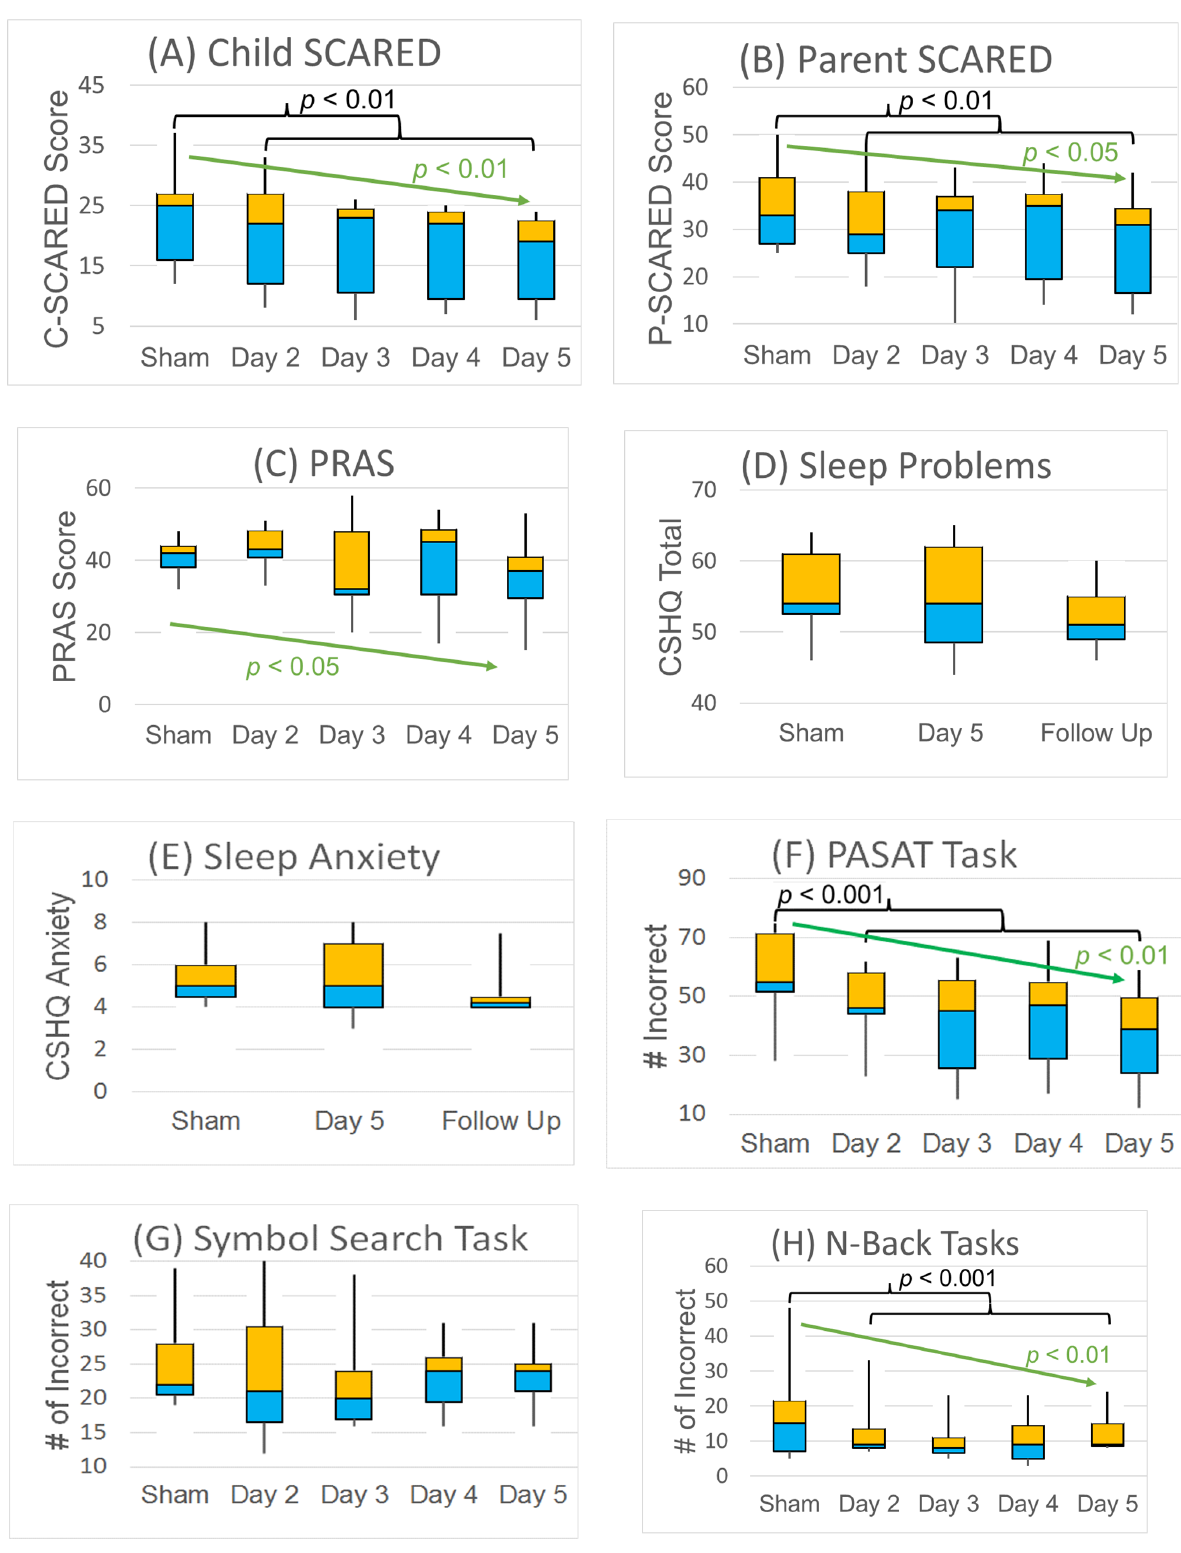
Figure 4. Effects of TEN treatment on ( A – C ) anxiety, ( D , E ) sleep and ( F – H ) cognitive performance ( n = 7). Median, quartiles and min and max are shown. Black brackets represent significant differences between the sham day and TEN days (days 2–5). Green arrows represent significant trends in outcome with more treatment